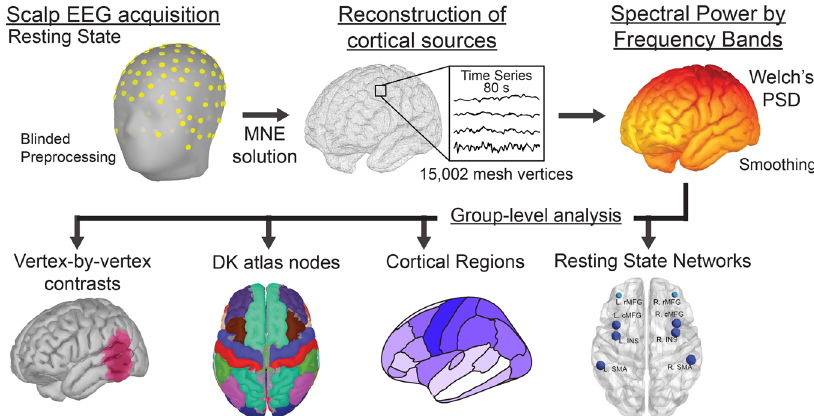
Fig. 1 Overview of Methodology. Principal steps of investigation: Following blinded preprocessing, artifact-free EEG data and a cortical lead fi eld matrix were used to construct a weighted minimum norm estimate (MNE) source model to estimate current source density and spectral power by frequency band at each vertex of a triangular cortical mesh. Based on hypotheses, subsequent analyses were performed at four different levels: raw vertices, parcellation of vertex points into Desikan – Killiany atlas-based nodes, cortical regions (contiguous anatomical grouping of nodes), and/or resting-state networks (RSN) (functional non-continuous grouping of